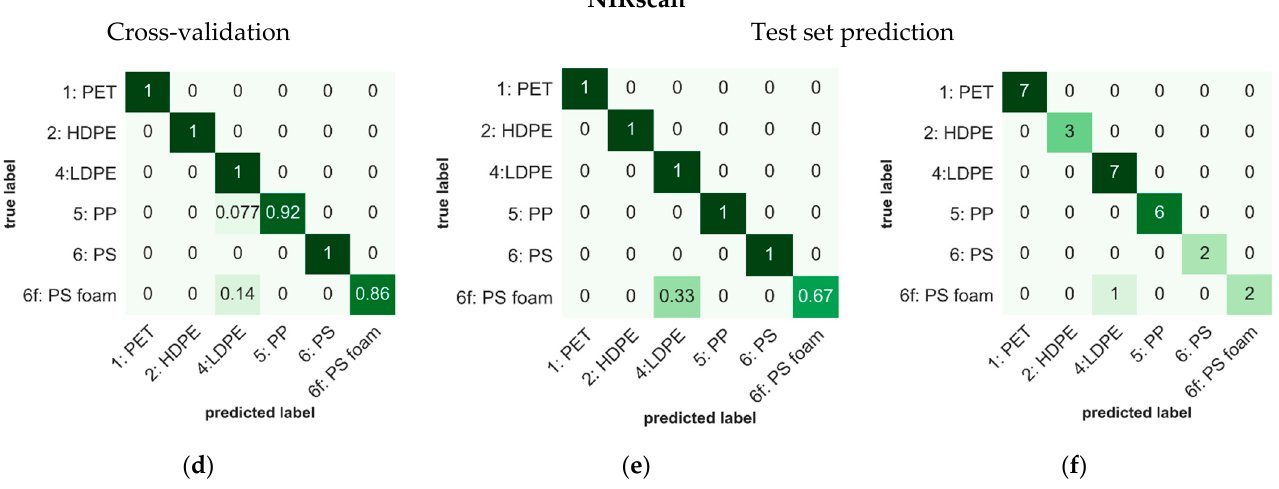
Figure 5. Results of plastic type classification using the SpectraPod (top, a – c ) and NIRscan (bottom, d – f ) measurements. Confusion matrices display the outcome of PLS-DA classification on the calibration (left: relative frequency) and test sample set (middle: relative frequency, right: absolute frequency). One hundred percent accuracy was obtained by the SpectraPod for both cross-validation and test set prediction. Accuracies of 96.9% and 96.4% were obtained by the NIRscan for cross-validation and test set prediction, respectively.